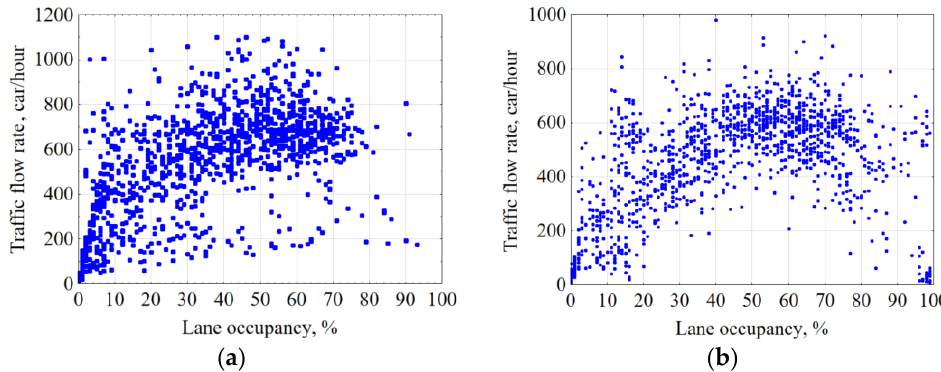
Figure 8. Cumulative sample of initial data on traffic flow rate and occupancy of lanes in ( a ) left-turn and ( b ) forward directions of traffic flow.